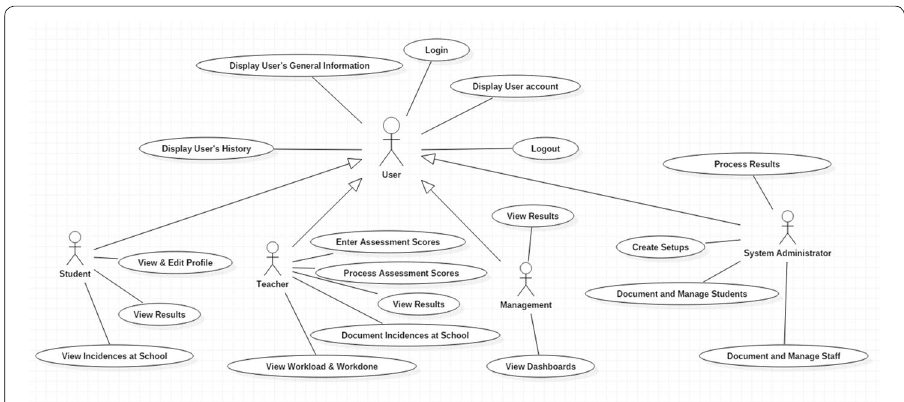
Fig. 11 Use-Case Diagram of the Functionalities of a School Management Software